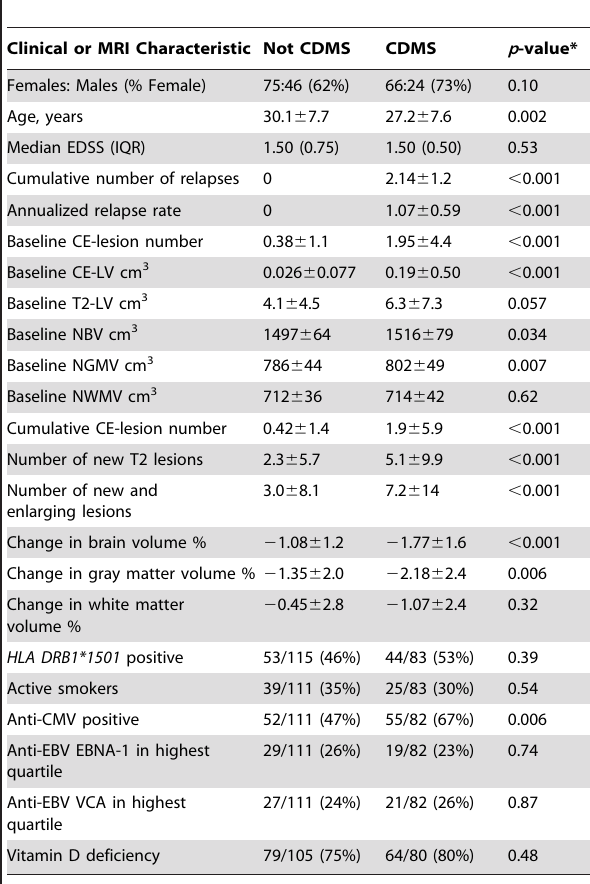
The continuous variables are expressed as mean 6 SD and the categorical variables as frequency